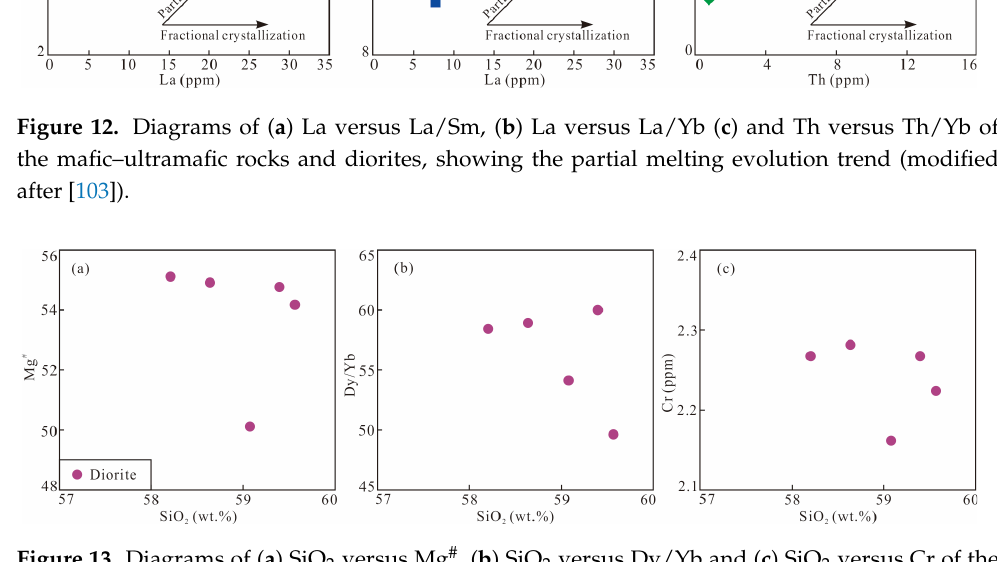
Figure 13. Diagrams of ( a ) SiO 2 versus Mg # , ( b ) SiO 2 versus Dy/Yb and ( c ) SiO 2 versus Cr of the diorites, documenting the low probability of fractional crystallization from mafic–ultramafic magma (modified after